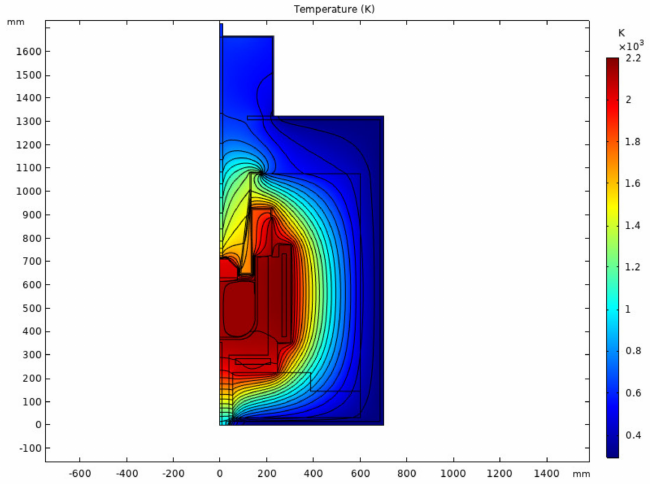
Figure 2. Temperature distribution in the process system.